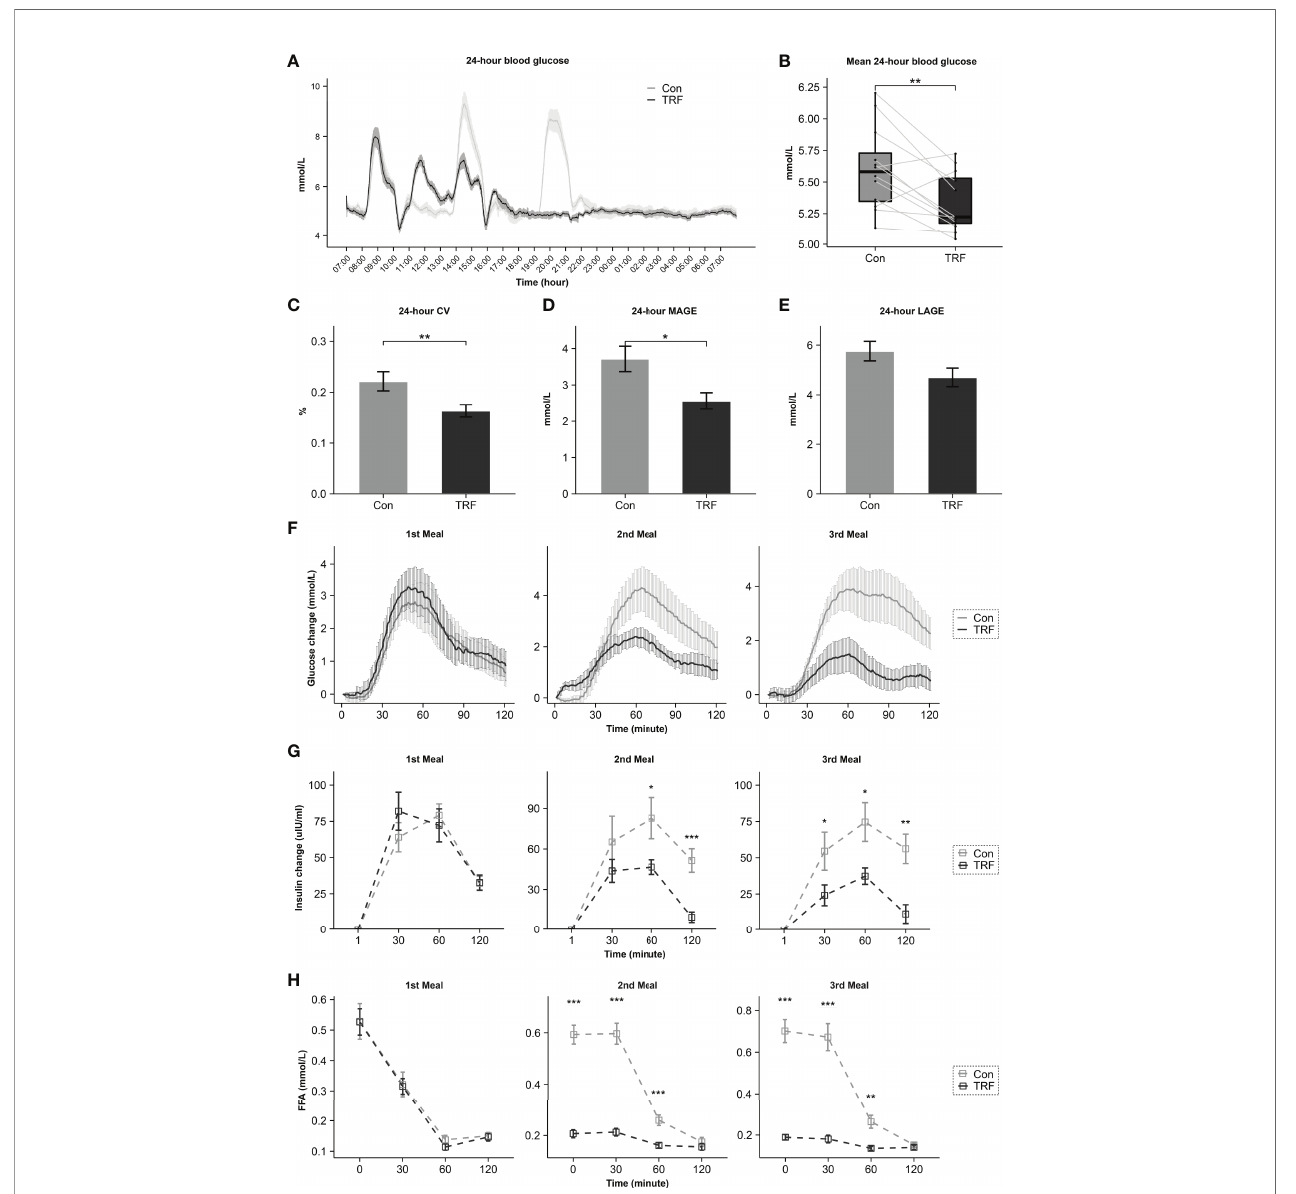
FIGURE 5 | The effect of TRF on 24-hour CGM data (A) . Comparison of 24-hour mean glucose (B) , CV (C) , MAGE (D) , LAGE (E) , postprandial glycemic (F) , postprandial insulin (G) , and postprandial FFA (H) between control and TRF groups. Data are mean ± SEM, *P <0.05, **P<0.01,